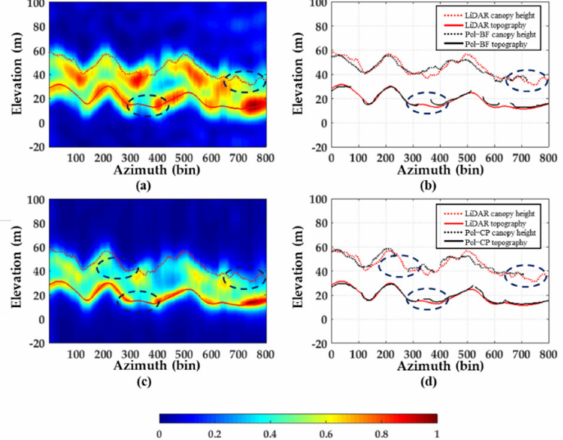
Figure 10. The normalized tomograms of test line1 estimated by traditional PolTomoSAR methods and the forest height and underlying topography extracted from the tomograms: ( a ) tomogram estimated using Pol-beamforming method; ( b ) forest height and underlying topography of test line1 estimated using Pol-beamforming method; ( c ) tomogram estimated using Pol-Capon method; ( d ) forest height and underlying topography of test line1 estimated using Pol-Capon